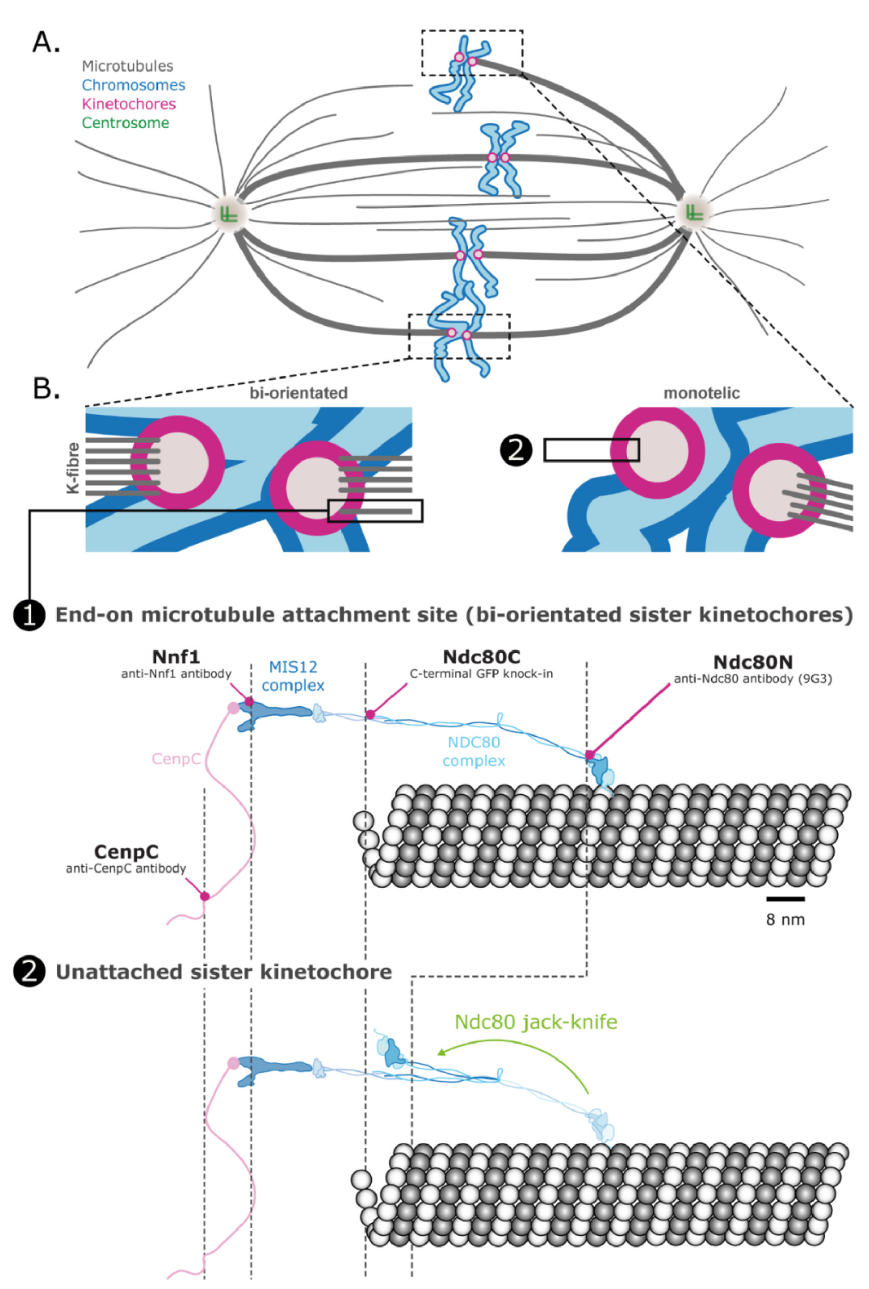
Fig 5. Spindle and kinetochore organisation. A . Schematic of the spindle and chromosome attachment to the spindle poles. Chromatids are bi-orientated with microtubule attachments to both spindle poles, except the top chromatid pair where only one kinetochore is attached to a spindle pole (termed monotelic). B . Detail of monotelic and bi-orientated sister pairs. The kinetochores are in states 1. (attached) or 2. (unattached), shown below. State 1 (attached). Molecular detail of the Ndc80 complex showing its attachment to the side of a microtubule at its N-terminal binding site. The Ndc80 is attached to the Mis12 complex at its C-terminus. Nnf1, a component of the Mis12 complex, binds CenpC through an unstructured linkage. State 2 (unattached). The Ndc80 complex is hinged—in the unattached state the Ndc80 complex jack-knifes bringing the N and C termini closer together. A kinetochore has about 200–250 Ndc80 complexes and is bound to around 20 microtubules in mature attachment. The approximate positions of the four fluorophores discussed in this paper are shown in purple. Analysis of the geometry of the three triplets CenpC– CenpC–CenpC, CenpC–Ndc80C–Ndc80N and Nnf1–Ndc80C–Ndc80N is given in Tables 3 and 4. Molecules (Ndc80, Mis12 and tubulin heterodimer) are shown approximately to scale from structural biology considerations. Scale bar is